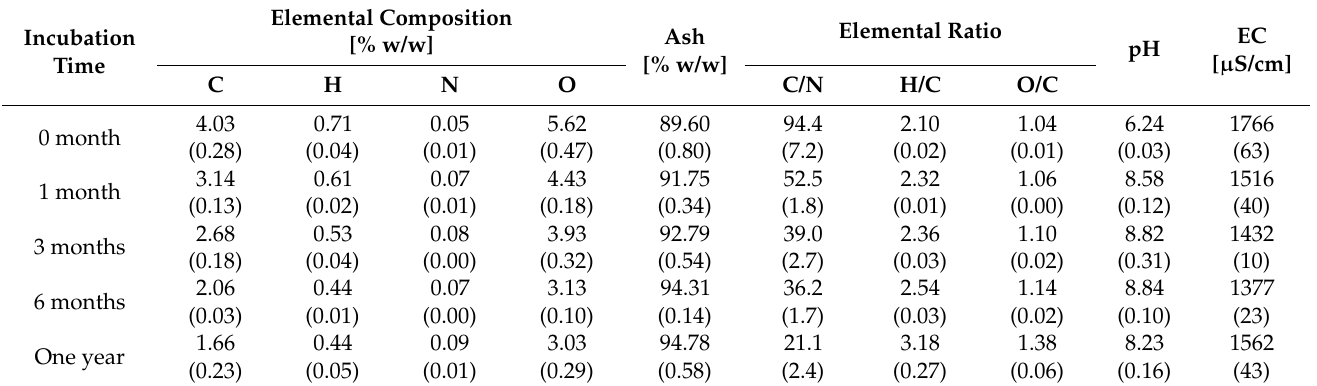
Table 1. Elemental composition, pH, and EC of rice straw-artificial soil mixtures.